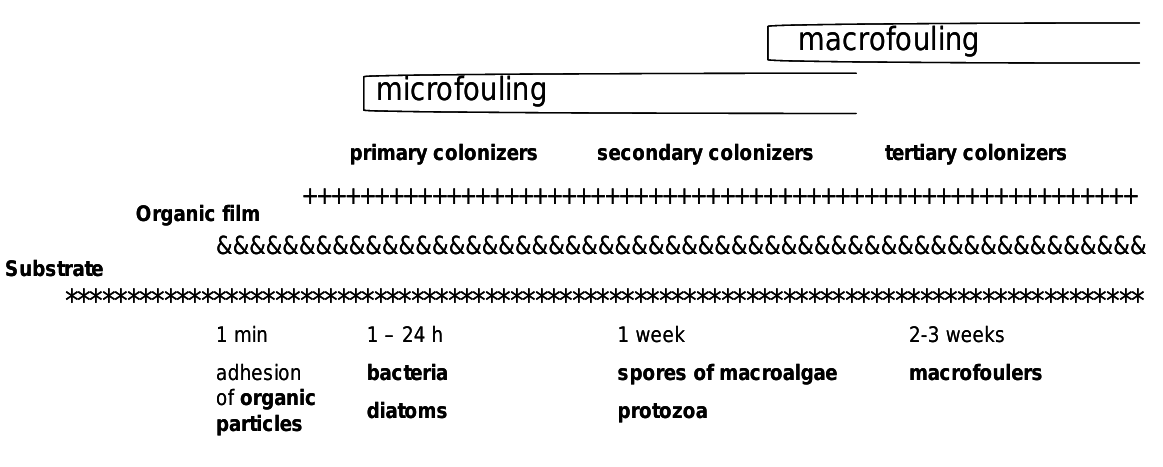
Figure 1. Temporal organization of biofouling (modified from